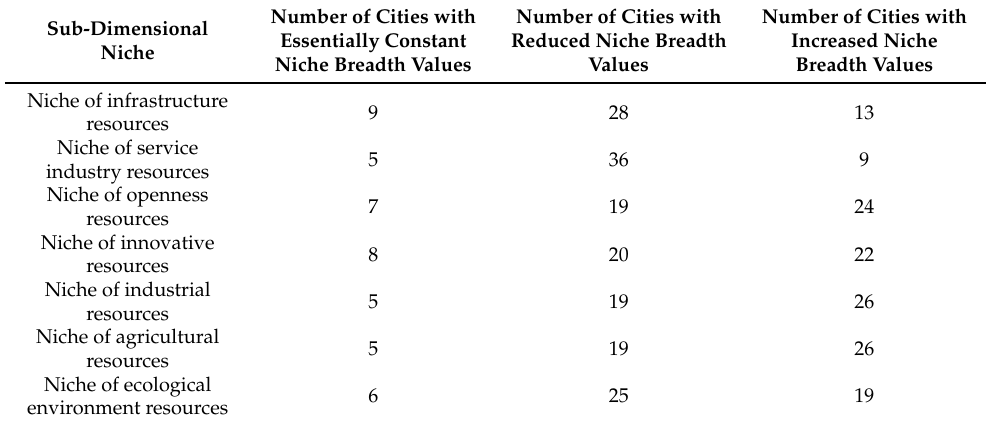
Table 4. Changes in sub-dimensional niche breadth of the high-quality development of YRB cities from 2011 to